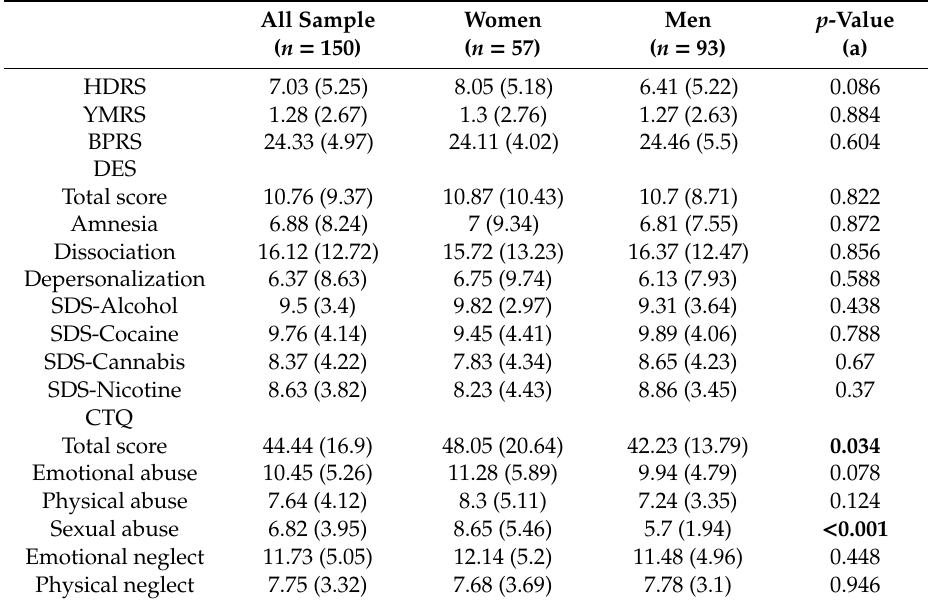
Table 5. Clinical di ff erences by gender. Data are presented as mean (SD). All